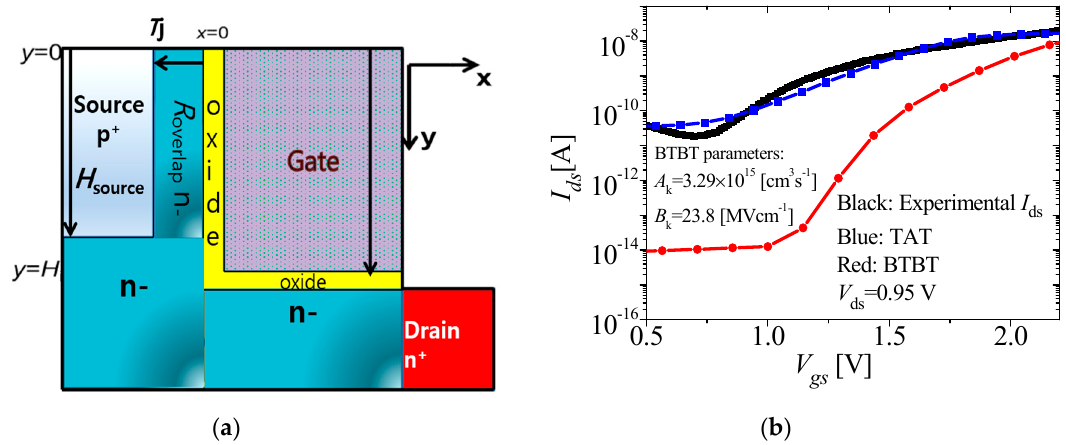
Figure 1. ( a ). Schematic of the L-shaped tunneling field-effect-transistor (LTFET). ( b ) Black: I ds – V gs characteristics of experimental LTFET [12], blue: trap-assisted-tunneling (TAT) current calculated using the trap distribution and method in [13], and red: Band-to-band tunneling (BTBT) current fitted using dynamic nonlocal BTBT current [10].